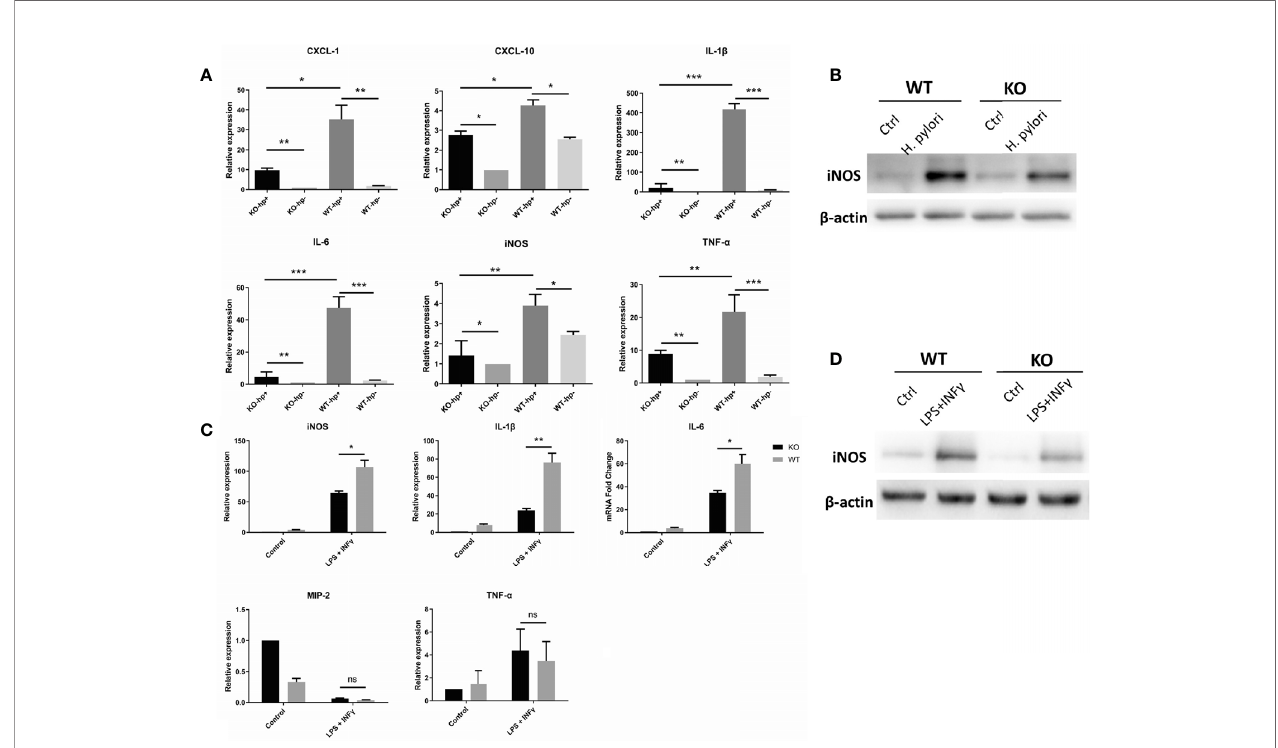
FIGURE 5 | Heparanase promotes the polarization of macrophages to the M1 phenotype. (A) Peritoneal macrophages were isolated from WT and HPA-KO mice and were grown without or with H. pylori at 200 MOI for 6 h. Total RNA was then extracted, and the expression of IL-1 b , IL-6, TNF- a , CXCL-1, CXCL-10 and iNOS was evaluated by qPCR. (B, D) Immunoblotting. Peritoneal macrophages were collected from WT and Hpa-KO mice and were left untreated (ctrl) or were treated with H. pylori ( 200 MOI; B) , or LPS (50 ng/ml) plus interferon g ( 20 ng/ml ; D) for 6 h. Cell extracts were then prepared and subjected to immunoblotting applying anti-iNOS (upper panels) and anti-actin (lower panels) antibodies. (C) qPCR. Macrophages were collected from the peritoneum of WT and Hpa-KO mice and were left untreated or treated with LPS plus interferon-gamma (IFN- g ; 20 ng/ml) for 6 h. Total RNA was then extracted and the relative expression of the iNOS, IL-1 b , IL-6, TNF- a , MIP-2 and TNF- a was quanti fi ed by qPCR. *p <0.05; **p <0.01; ***p <=0.001; ns, no signi fi cant difference. KO-hp + : n = 3, KO-hp - : n = 3, WT-hp + : n = 3, WT-hp - : n = 3; KO control : n = 3, KO LPS + INF- g : n = 3, WT control : n = 3, WT-hp LPS + INF- g : n =